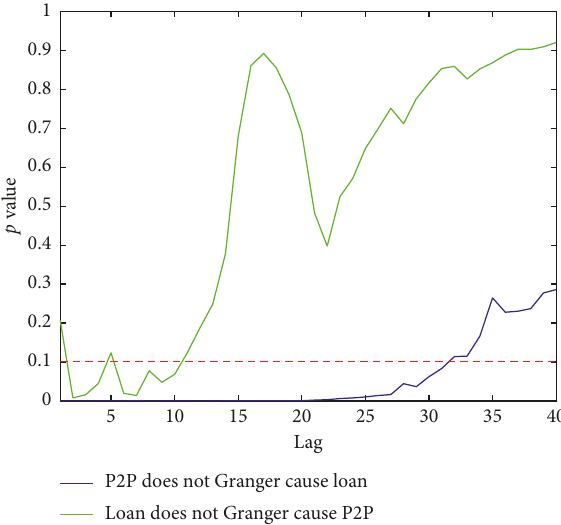
Figure 5: Granger causality test. The dashed line represents the significance level of 10%.